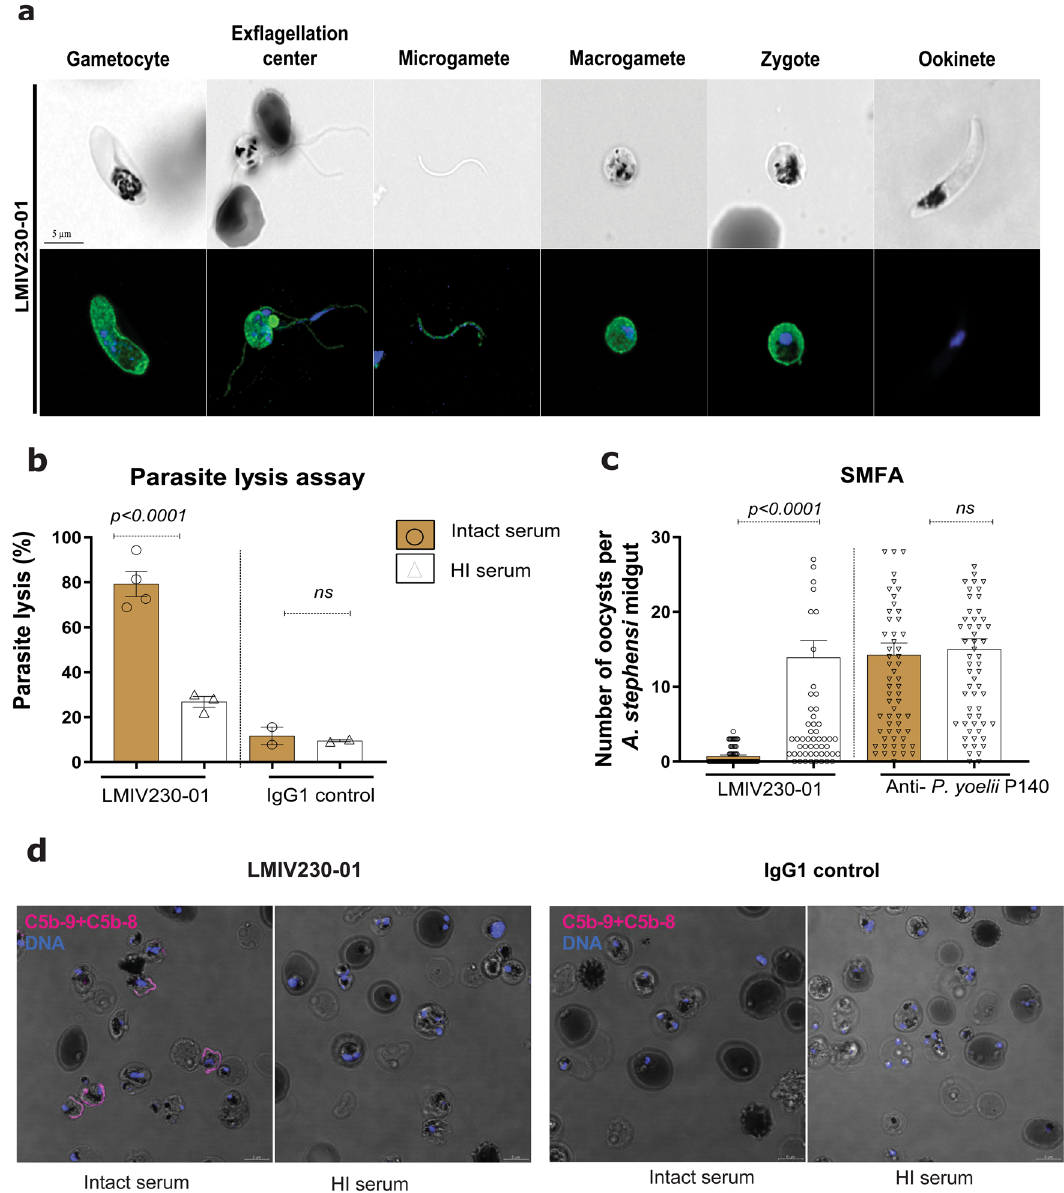
Fig. 2 LMIV230-01 binds to multiple parasite stages and its activity is complement-dependent. a LMIV230-01 binds to permeabilized gametocytes, gametes, and zygotes and does not bind to ookinetes. Parasites were fi xed and permeabilized, and 7.5 µ g/mL of antibody was used to stain the different parasite stages. Scale bars: 5 µ M. This experiment was performed in duplicate. b In vitro parasite lysis by LMIV230-01 is complement-dependent. Samples were tested in two independent assays, using two different parasite cultures. Data for LMIV230-02 mAb are shown in Supplementary Fig. 8a . c Functional activity of LMIV230-01 is also complement-dependent in vivo (SMFA with mosquitoes). Data from three independent SMFA assays. N ≥ 20 mosquitos per assay. Data for LMIV230-02 mAb are shown in Supplementary Fig. 8b. Oocyst averages in the control mosquitoes (fed with IgG1 targeting P. yoelli P140) for each of the experiments were: exp. 1 = 4.55; exp. 2 = 20.50, exp. 3 = 5.86. Data obtained from mosquitoes fed with LMIV230-01 at 1000 µ g/mL with intact sera were also used to generate Fig. 1f. Values are shown as mean ± s.e.m. One-Way ANOVA and Tukey ’ s multiple comparisons test were used to compare the different groups. d Live imaging of P. falciparum NF54 female gametes incubated with LMIV230-01 in the presence of intact serum from a healthy donor revealed surface-deposited MAC (membrane attack complex) using anti-C5b-9 + C5b-8 antibody (magenta color). MAC deposition was not detected in the presence of heat-inactivated (HI) serum. Scale bars: 5 µ M. This experiment was performed in triplicate. Source data are provided as a Source Data fi